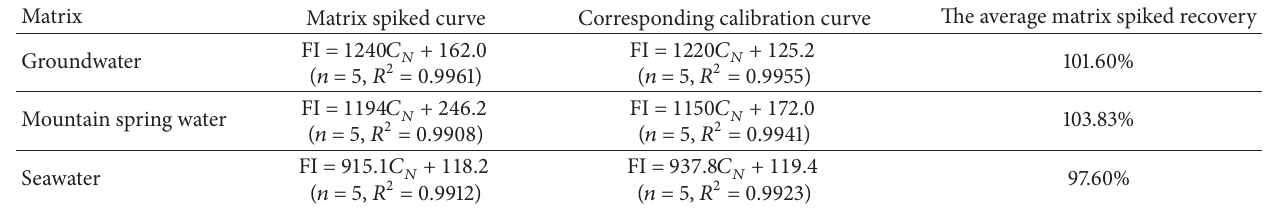
Table 4: The matrix spiked recovery.